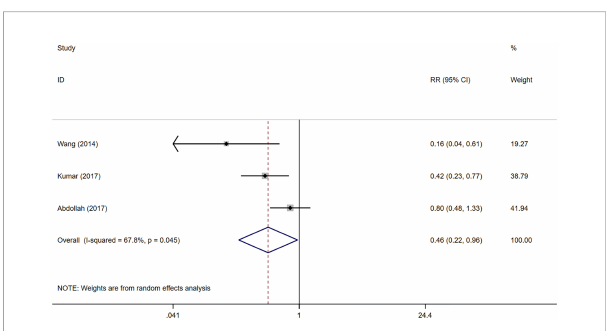
FIGURE 2 Forest plots of Continence recovery (12 month) for nerve sparing (NS) versus non-nerve sparing. CI, con fi dence interval; RR, Risk